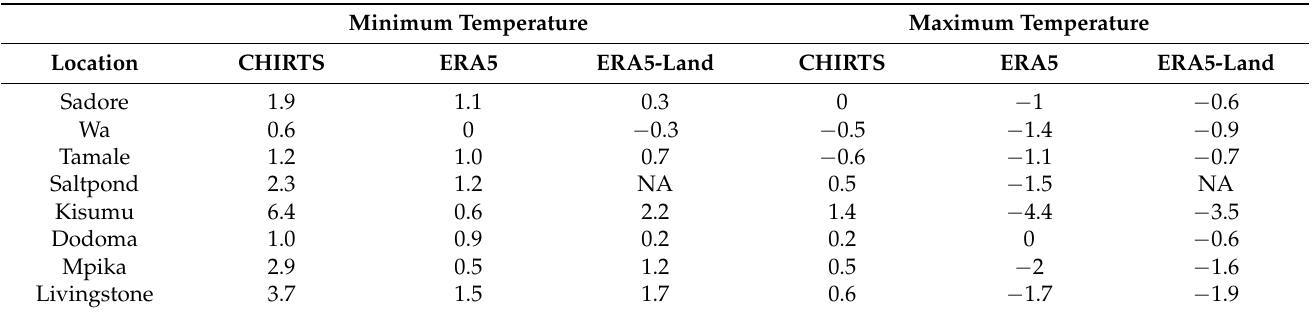
Figure 6. Scatter plots of station minimum temperature vs CHIRTS (blue) and ERA5 (red) for each month at Sadore, Niger. Table 3. Bias ( ◦ C) between the three gridded products and the station data daily minimum and maximum temperatures at each of the eight